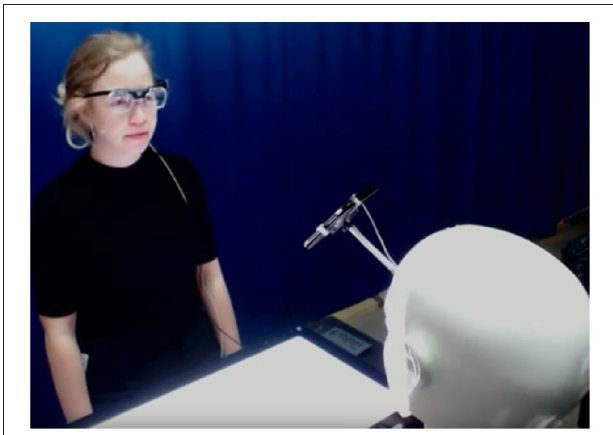
FIGURE 4 | Participant wearing the Tobii glasses during the interaction